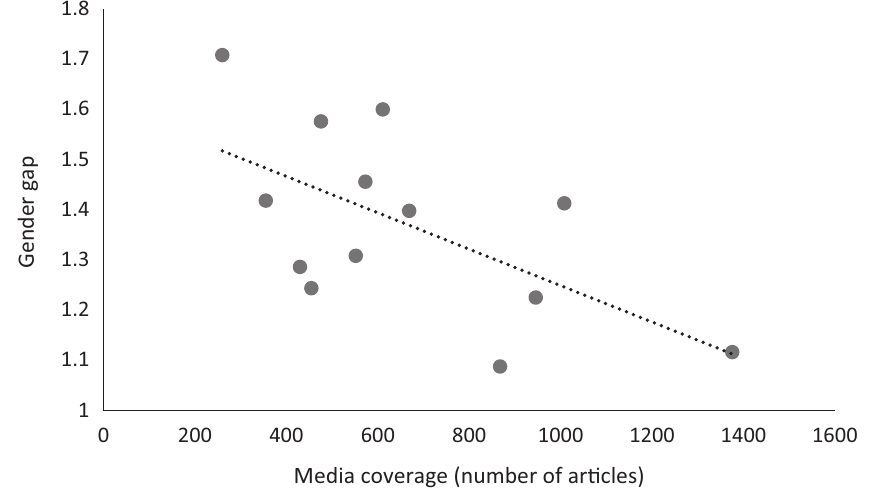
Figure 1. Correlation between the amount of media coverage and the degree of the gender gap in social media use by